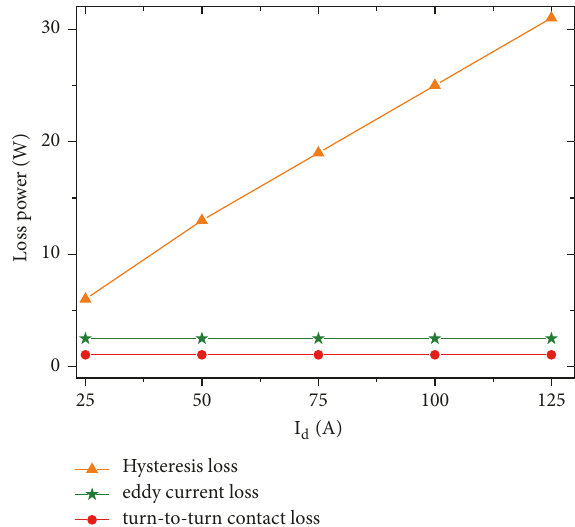
, with a constant K of 50 A/s. d